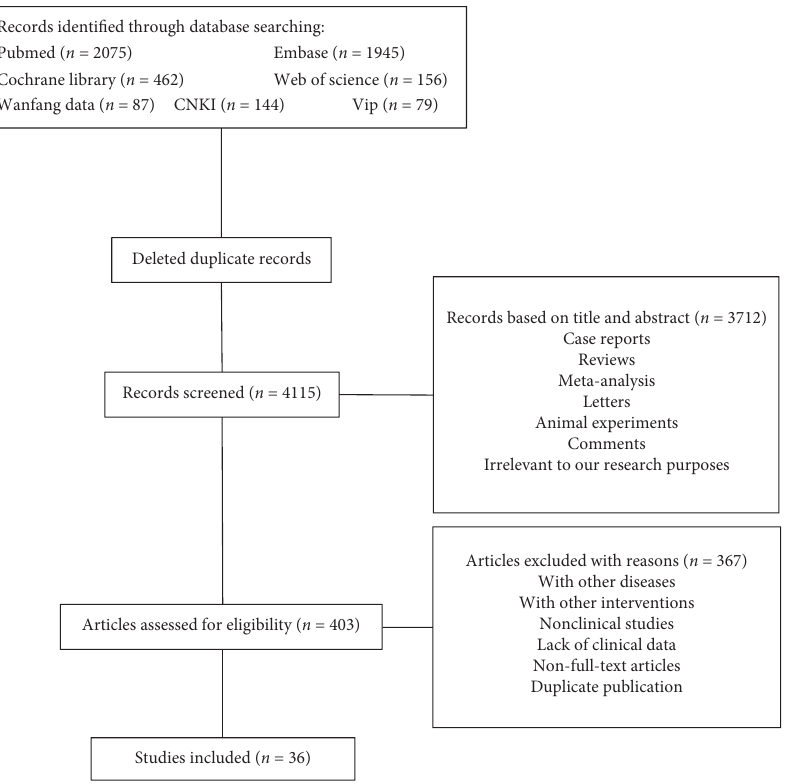
Figure 1: Flow chart of literature CI: 1.07 ∼ 10.37, P � 0 . 04) (Figure 6(c)) (see Supplementary Figure 4 for histogram).